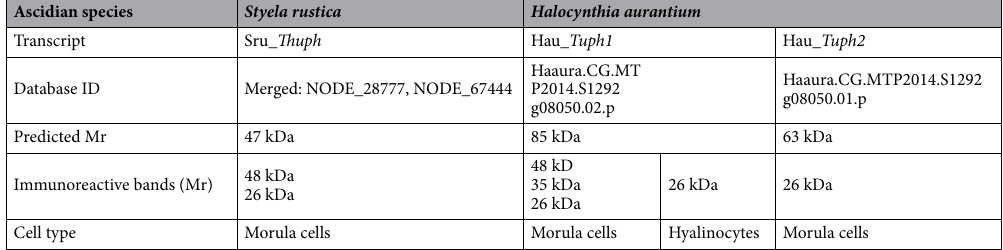
Table. 2. Protein products encoded by Tuphoxin of S. rustica and H. aurantium.